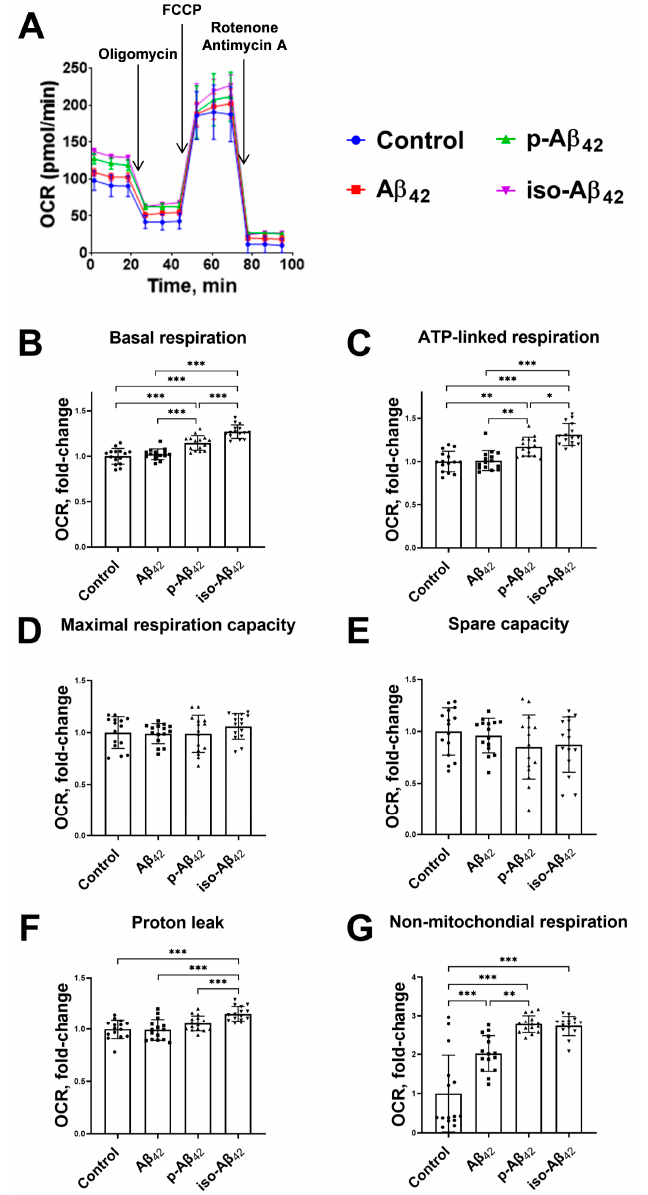
Figure 8. The effects of beta-amyloid isoforms on the bioenergetic functions in bEnd.3 cells after 48 h incubation. Cells were incubated with 10 µ M of A β 42 , p-A β 42 and iso-A β 42 . ( A ) Representative raw data of bioenergetic function. ( B ) Basal respiration, ( C ) ATP-linked respiration, ( D ) maximal respiration capacity, ( E ) spare capacity, ( F ) proton leak and ( G ) non-mitochondrial respiration are demonstrated. The results were calculated based on the data obtained from bioenergetic functional analysis (for details, see Figure 5). The values in the control samples were taken as 1. All parameters